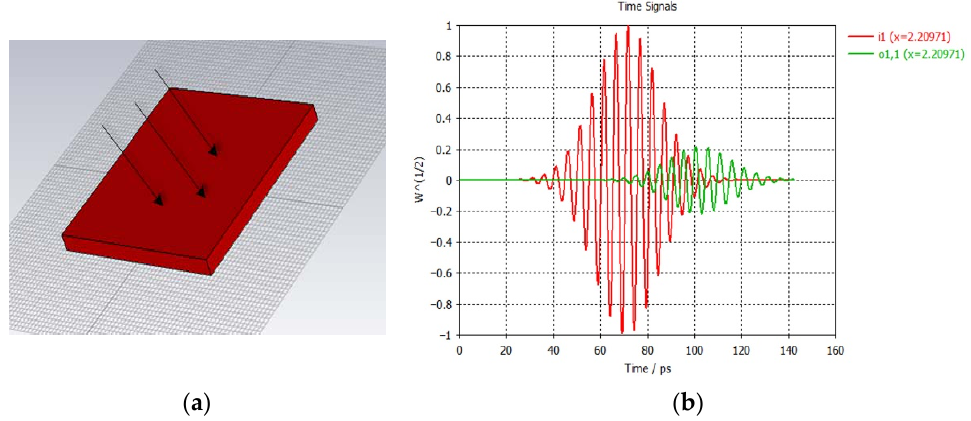
Figure 8. ( a ) PMVS material slice terahertz simulation model diagram. ( b ) THz incident and reflected pulse waveform diagram.